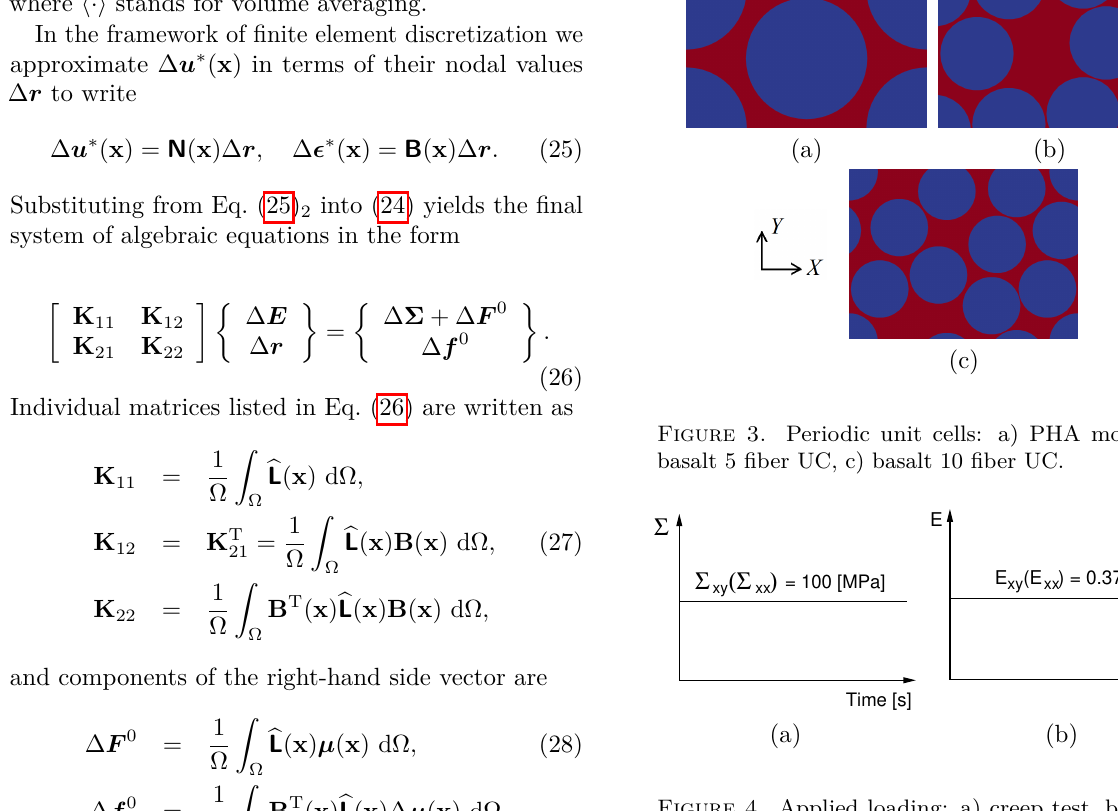
Figure 4. Applied loading: a) creep test, b) relax- ation